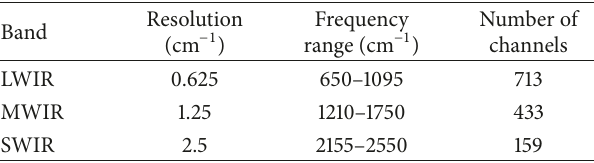
Table 1: Spectral resolution, frequency range, and number of channels of CrIS